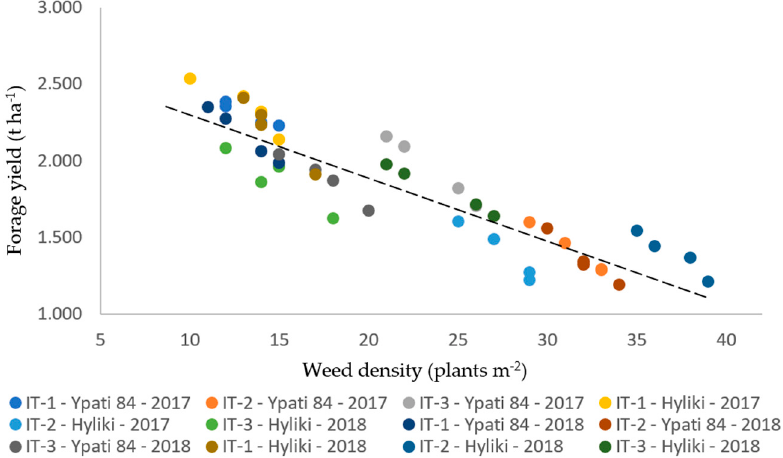
Figure 2. Linear regression between total weed density and alfalfa forage yield in the fourth harvest.